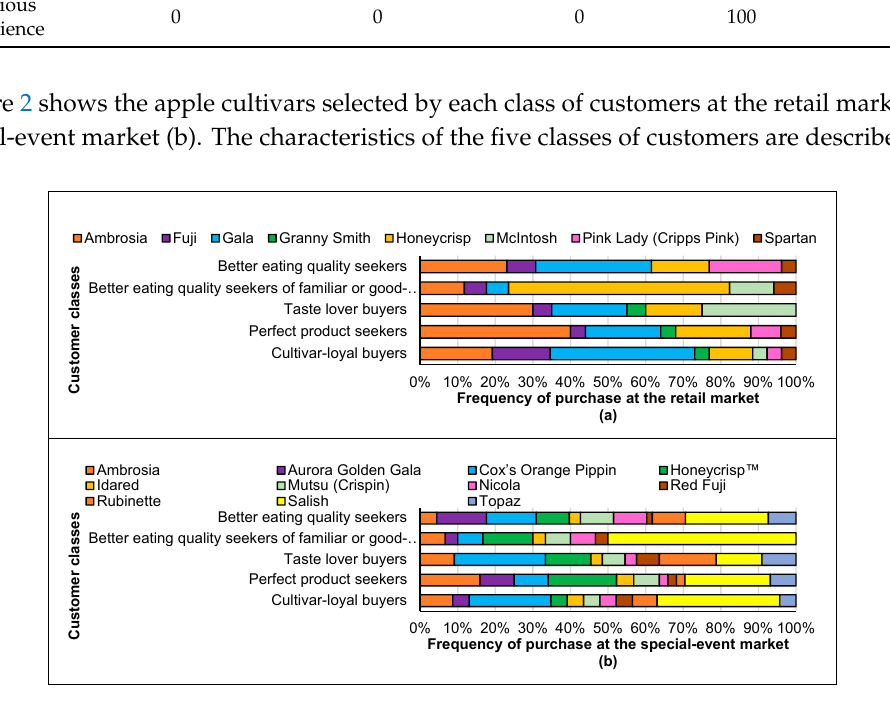
Figure 3. Age of the respondents in the different classes of consumers purchasing apples at the retail market ( a ) and special-event market ( b ).